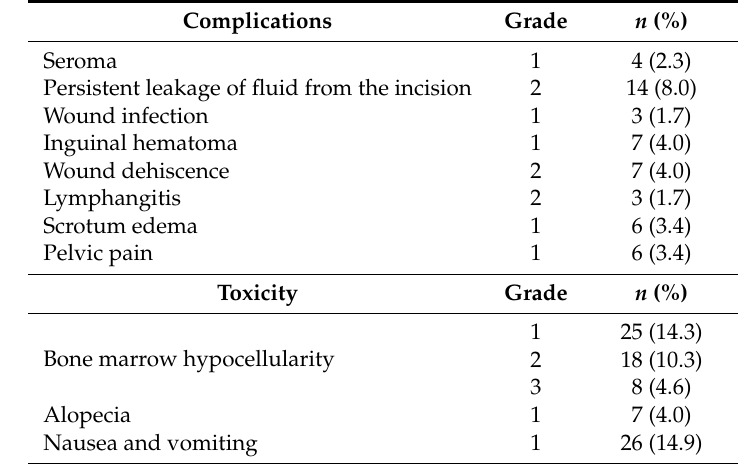
Procedure related complications and toxicity after 175 treatments in 41 metastatic melanoma